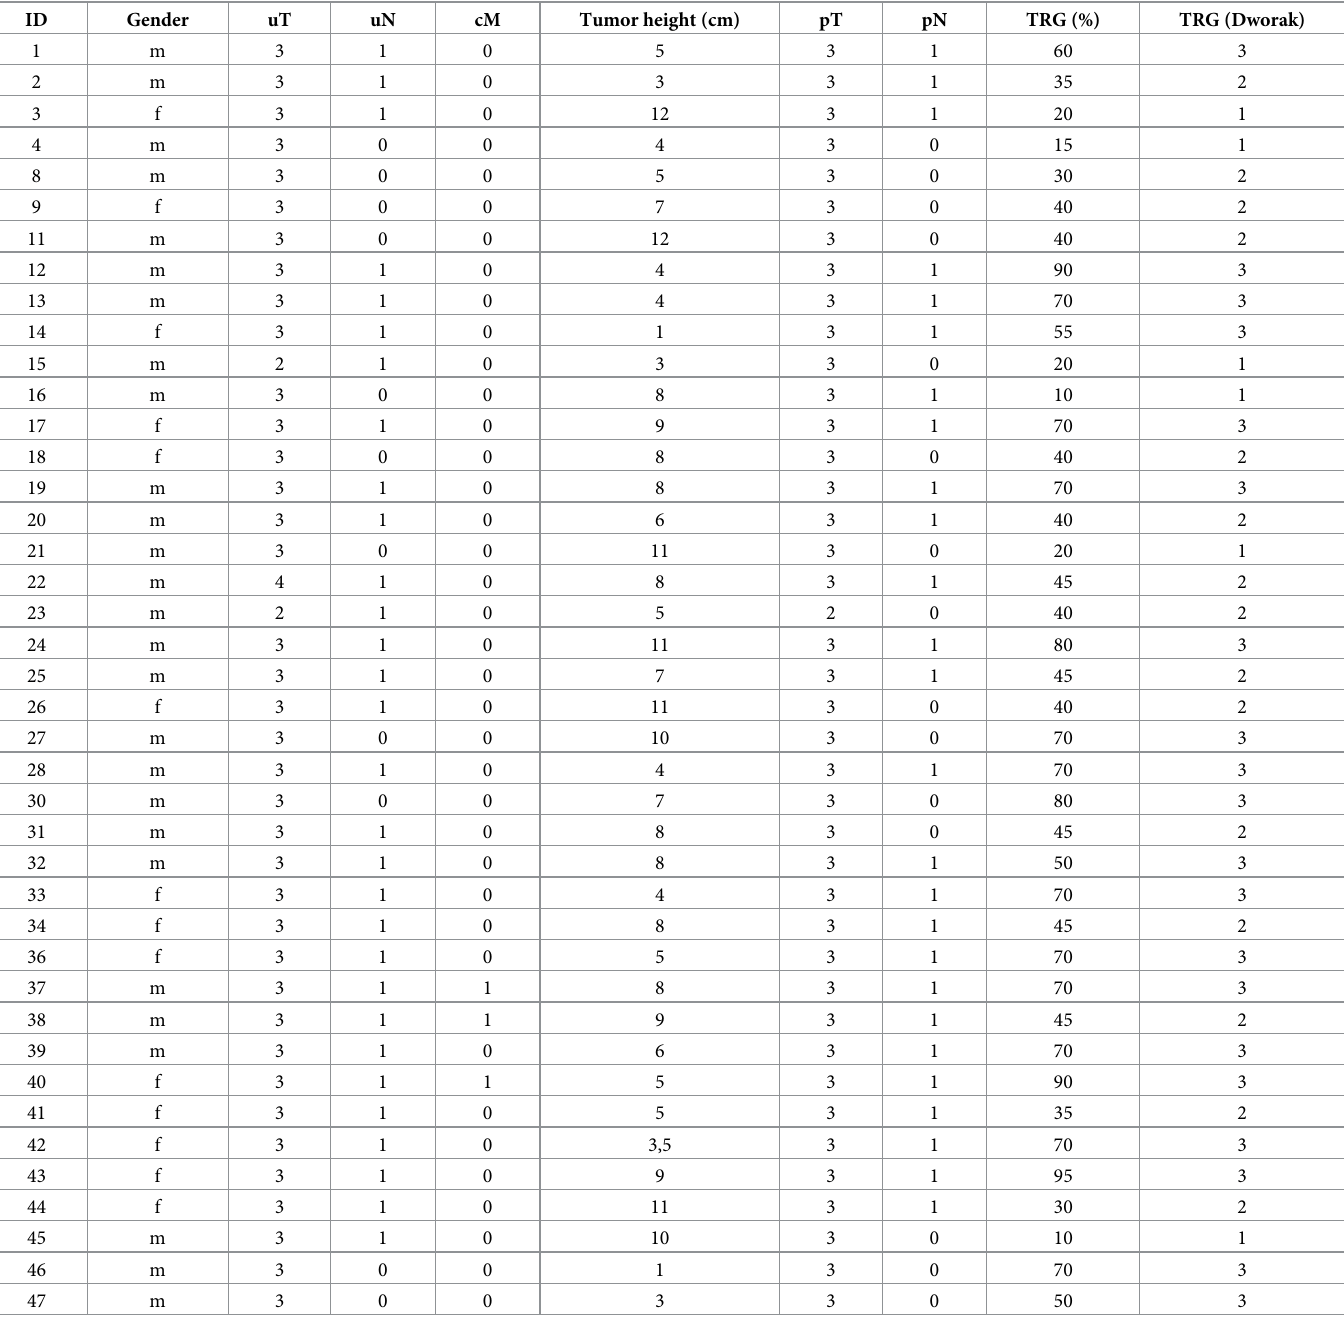
Table 1. Clinical data with tumor regression